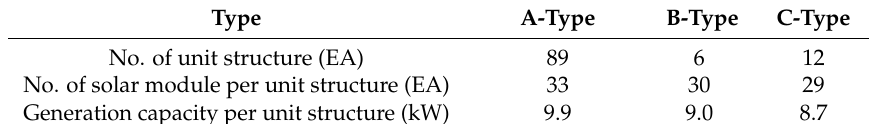
Table 1. No. and generation capacity of each unit structure.